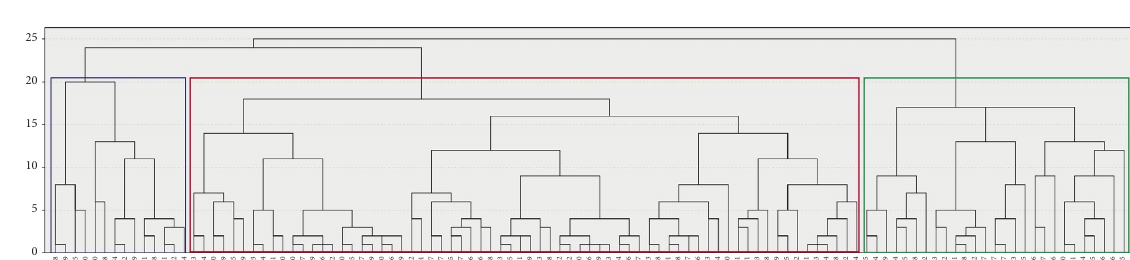
Figure 1: Cluster spectrum of bidding collusion cases.